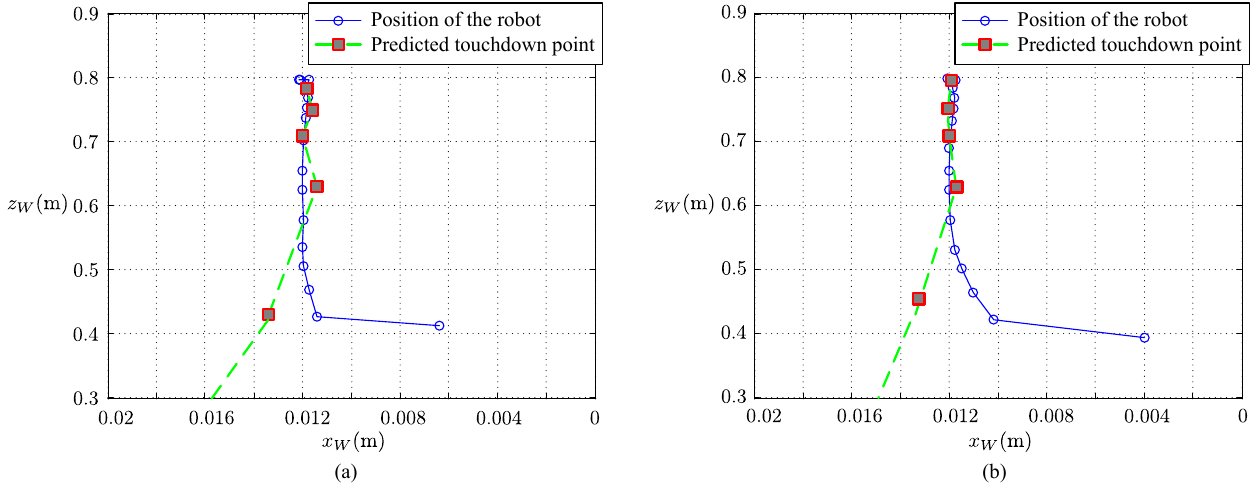
Figure 24. Moving path of the robot to catch the ball: ( a ) the previous work and ( b ) this